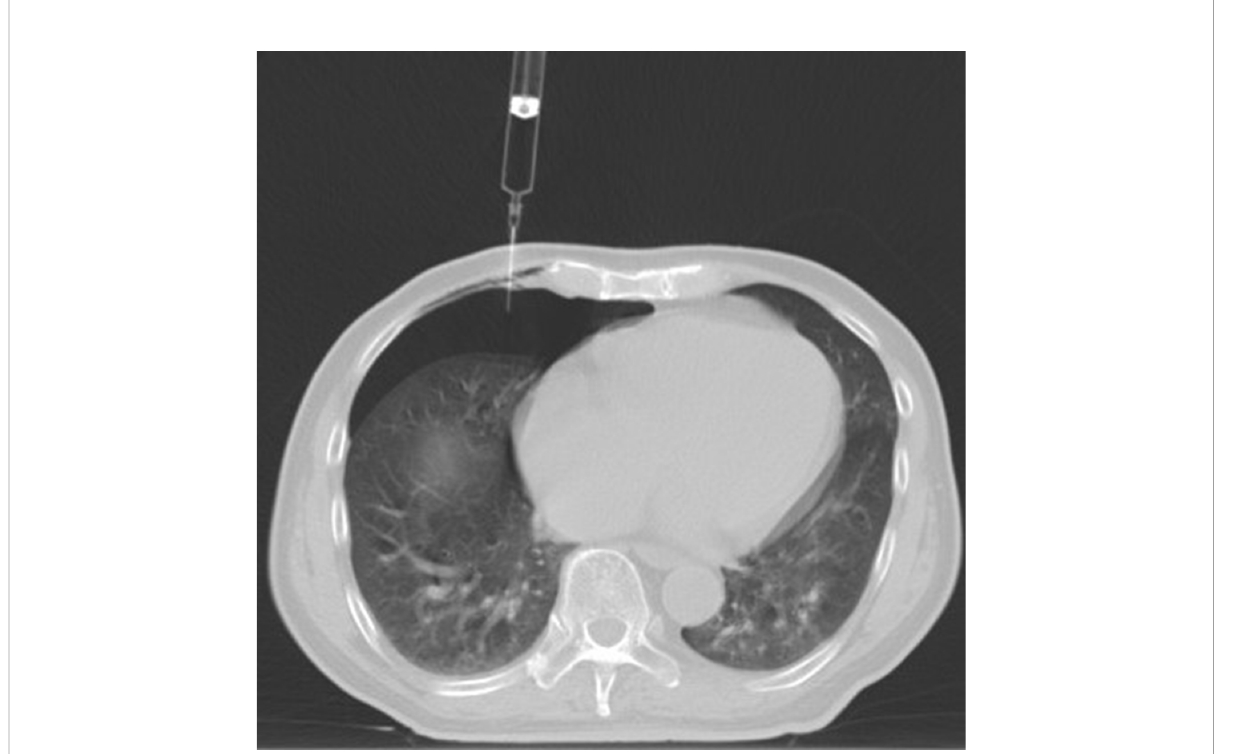
FIGURE 3 When the needle tip broke through the parietal pleura and the water column was drawn into the pleural cavity containing certain negative pressure, and an appropriate amount of air (100 ml) would be injected into the pleural cavity.